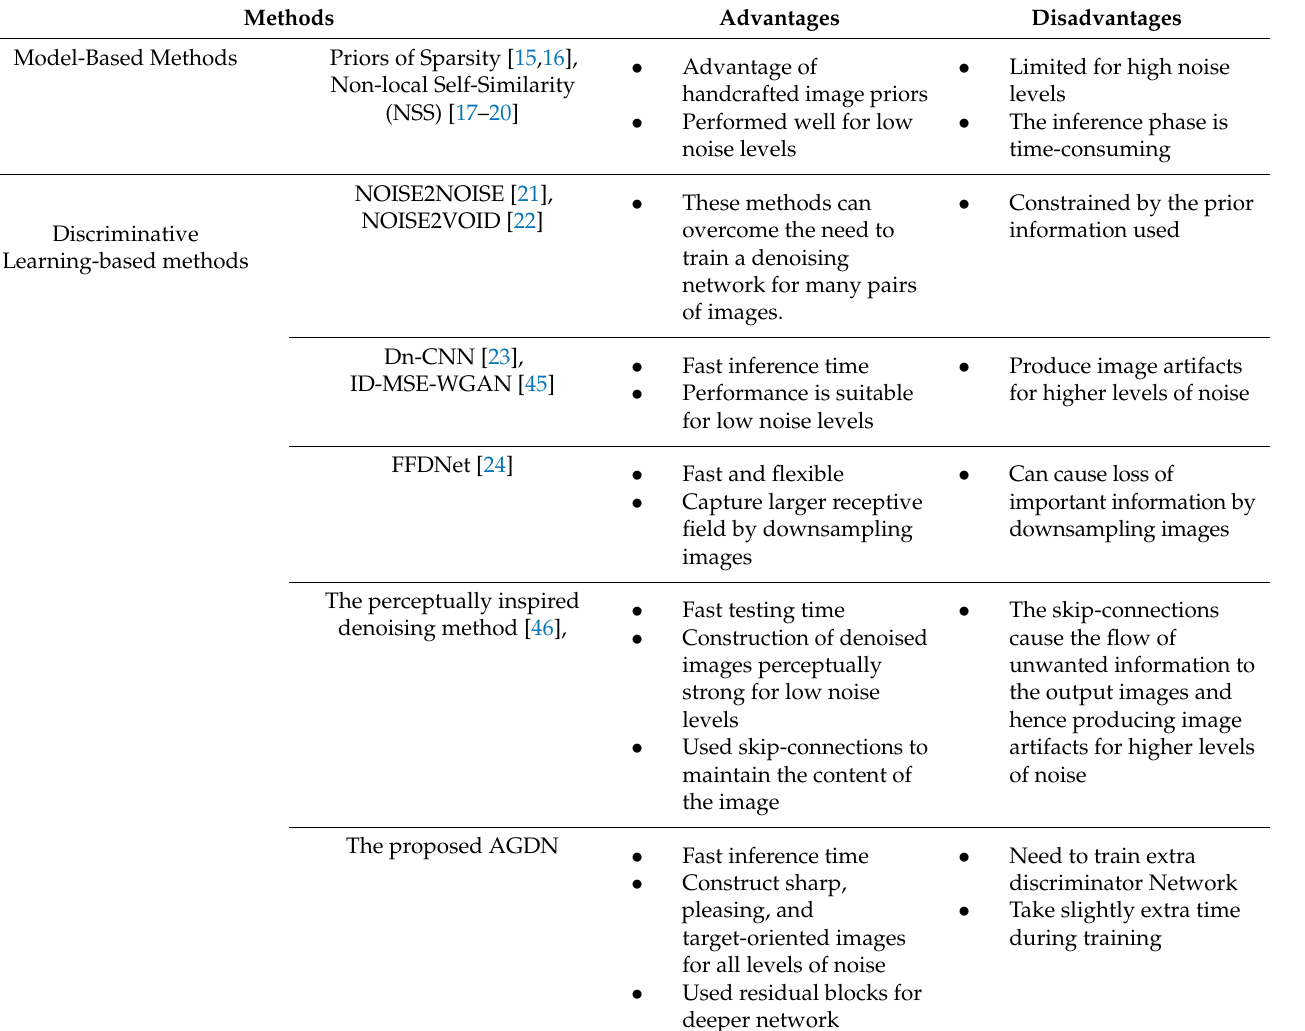
Table 1. Comparison of the proposed and state-of-the-art